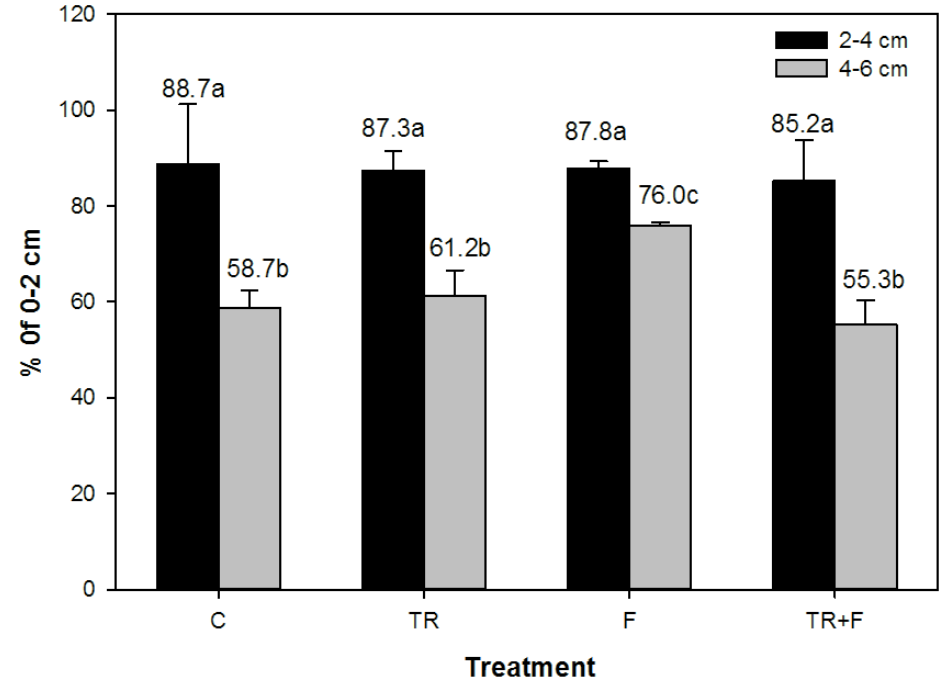
Figure 3. Sap flow rates at 2–4 cm and 4–6 cm depths expressed as a percentage of sap flow at 0–2 cm depth for control (C), throughfall reduction (TR), fertilizer application (F), and throughfall reduction and fertilizer application (TR+F) treatments. Percentage values shown above each bar; values followed by the same letter are not significantly different ( p = 0.05). Whiskers represent + 1 standard error.